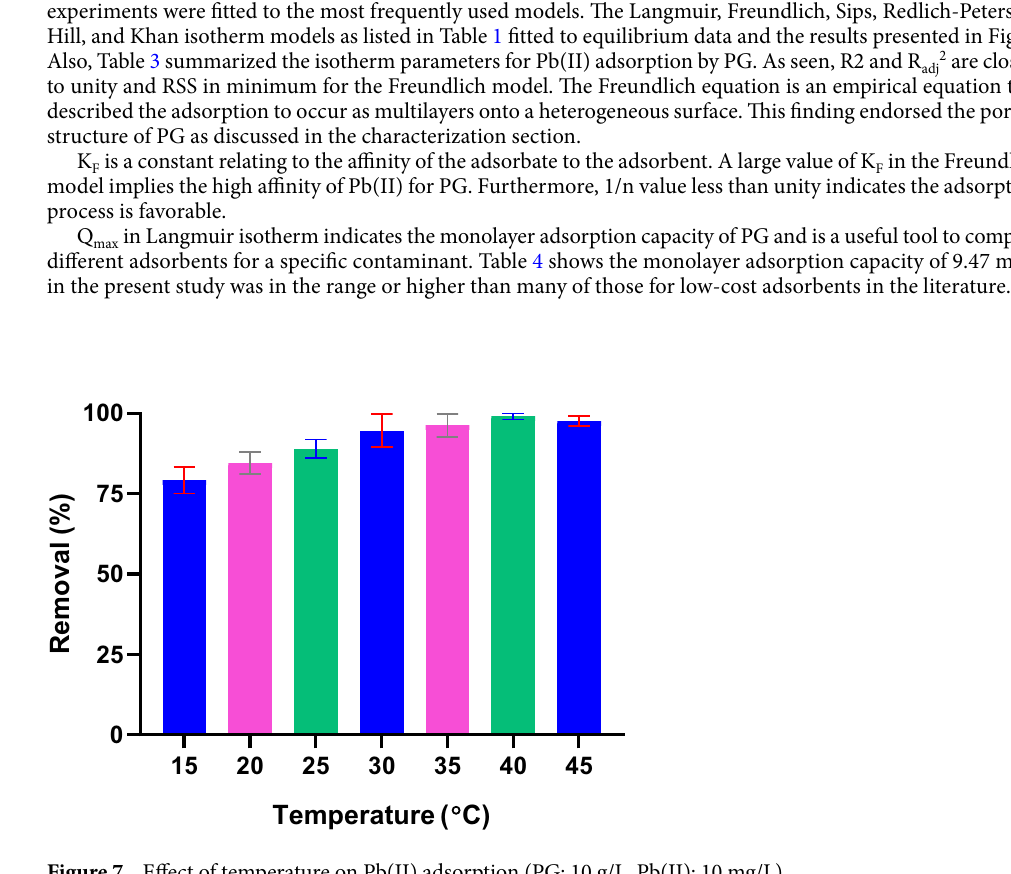
Figure 7. Effect of temperature on Pb(II) adsorption (PG: 10 g/L, Pb(II): 10